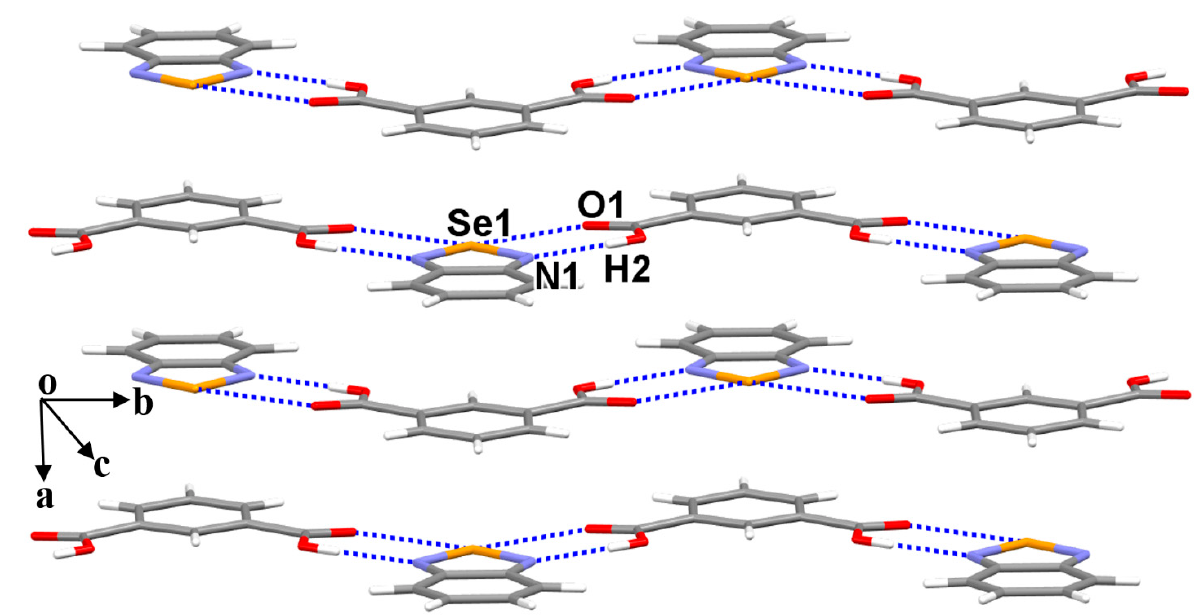
Figure 3. Part of the crystal structure of cocrystal 1 showing the O–H···N hydrogen bonds, N–Se···O chalcogen bonds and π ··· π stacking interactions.